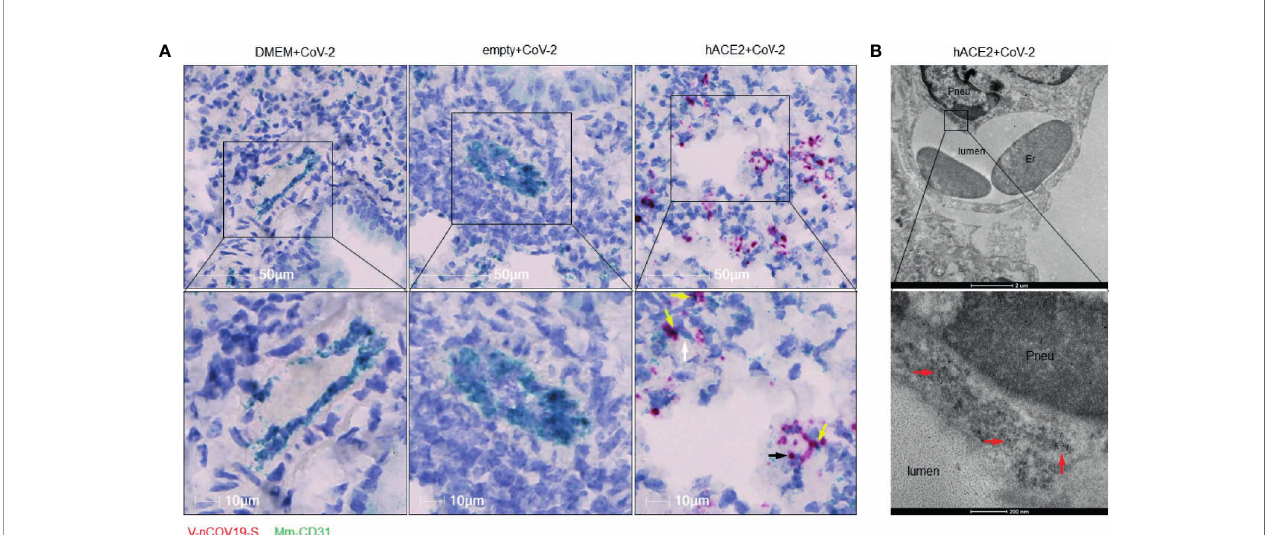
FIGURE 2 | RNA of SARS-CoV-2 spike protein can be found inside endothelial cells. (A) Representative RNAscope images showed co-localization of RNA of spike protein with CD31 RNA in SARS-CoV-2 infected Ad5-hACE2 mouse lungs (right panel, n = 2), but not in lungs of control mice transduced by DMEM (left panel, n = 3) or Ad5-empty (middle panel, n = 3). White arrow: Spike RNA signals showing light green; black arrow: CD31 RNA signals showing red; yellow arrows: co-localization of two RNAs showing purple. (B) Immunoelectron microscope showed SARS-CoV-2 proteins (black particles indicated by red arrows, n = 1) inside endothelial cells of infected Ad5-hACE2 mice lungs. Pneu, pneumocyte; Er,